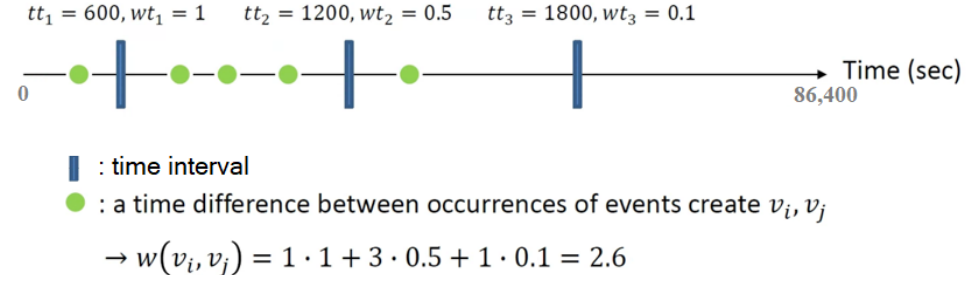
Figure 3. An example of the calculation of the weight function. A set of time thresholds ( TT ) and a set of weights corresponding to TT ( WT ) are